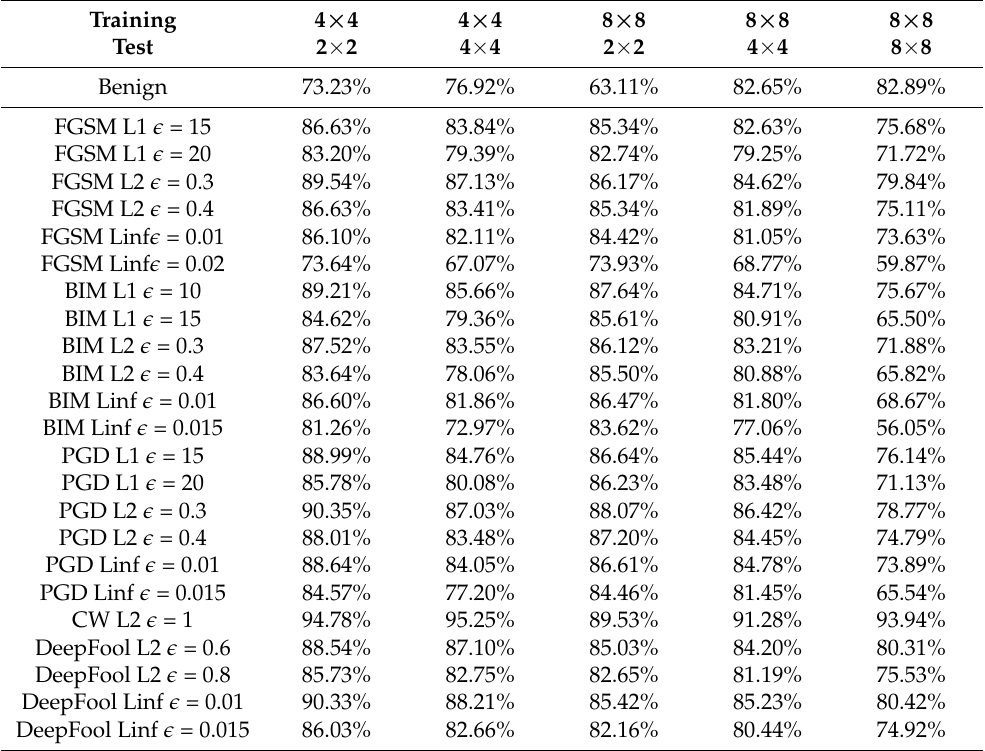
Table 3. Defense effects of different grid sizes with mask rate of 3/4 on VGG16 and CIFAR-10